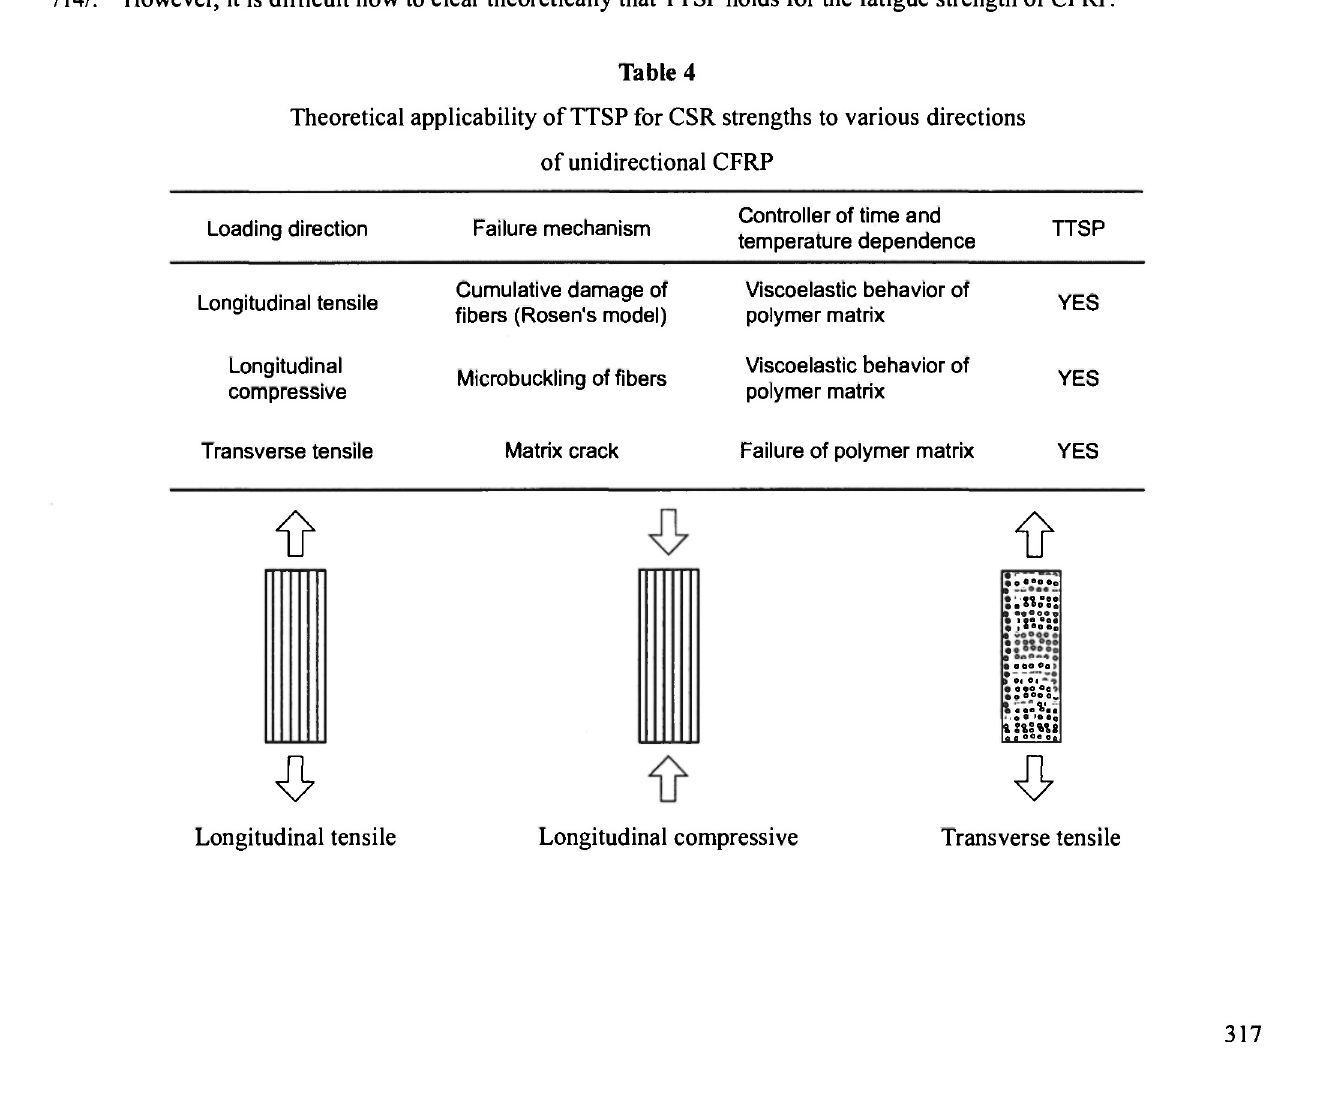
Theoretical applicability of TTSP for CSR strengths to various